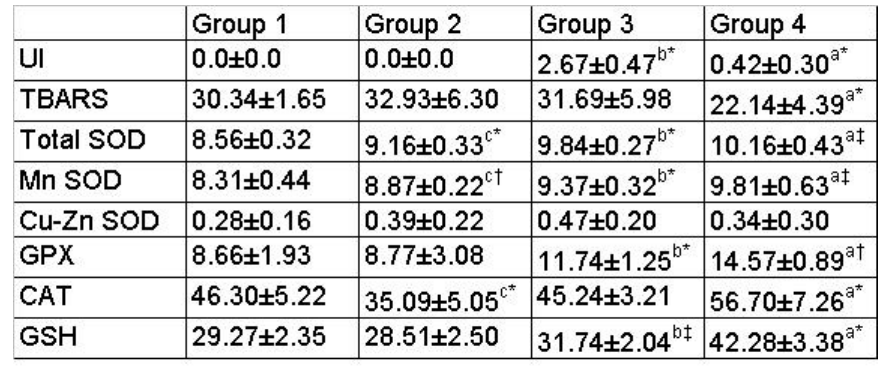
Effects of Saline or Taurine in Normal or Ibuprofen-Treated Rats on UI, TBARS, Total SOD, Mn-SOD, Cu-Zn SOD, GPX, CAT, and